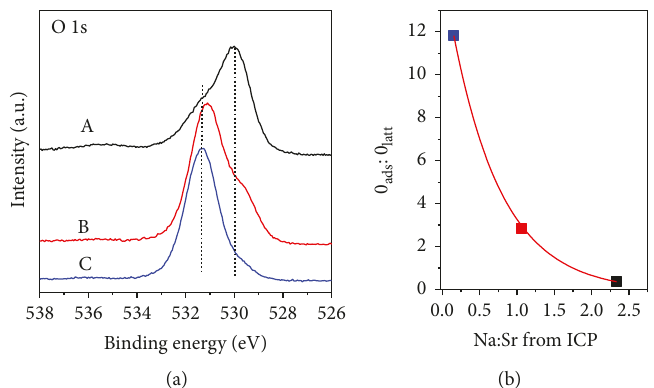
Figure 4: (a) O1s XPS lines obtained from samples and (b) the ratio of O